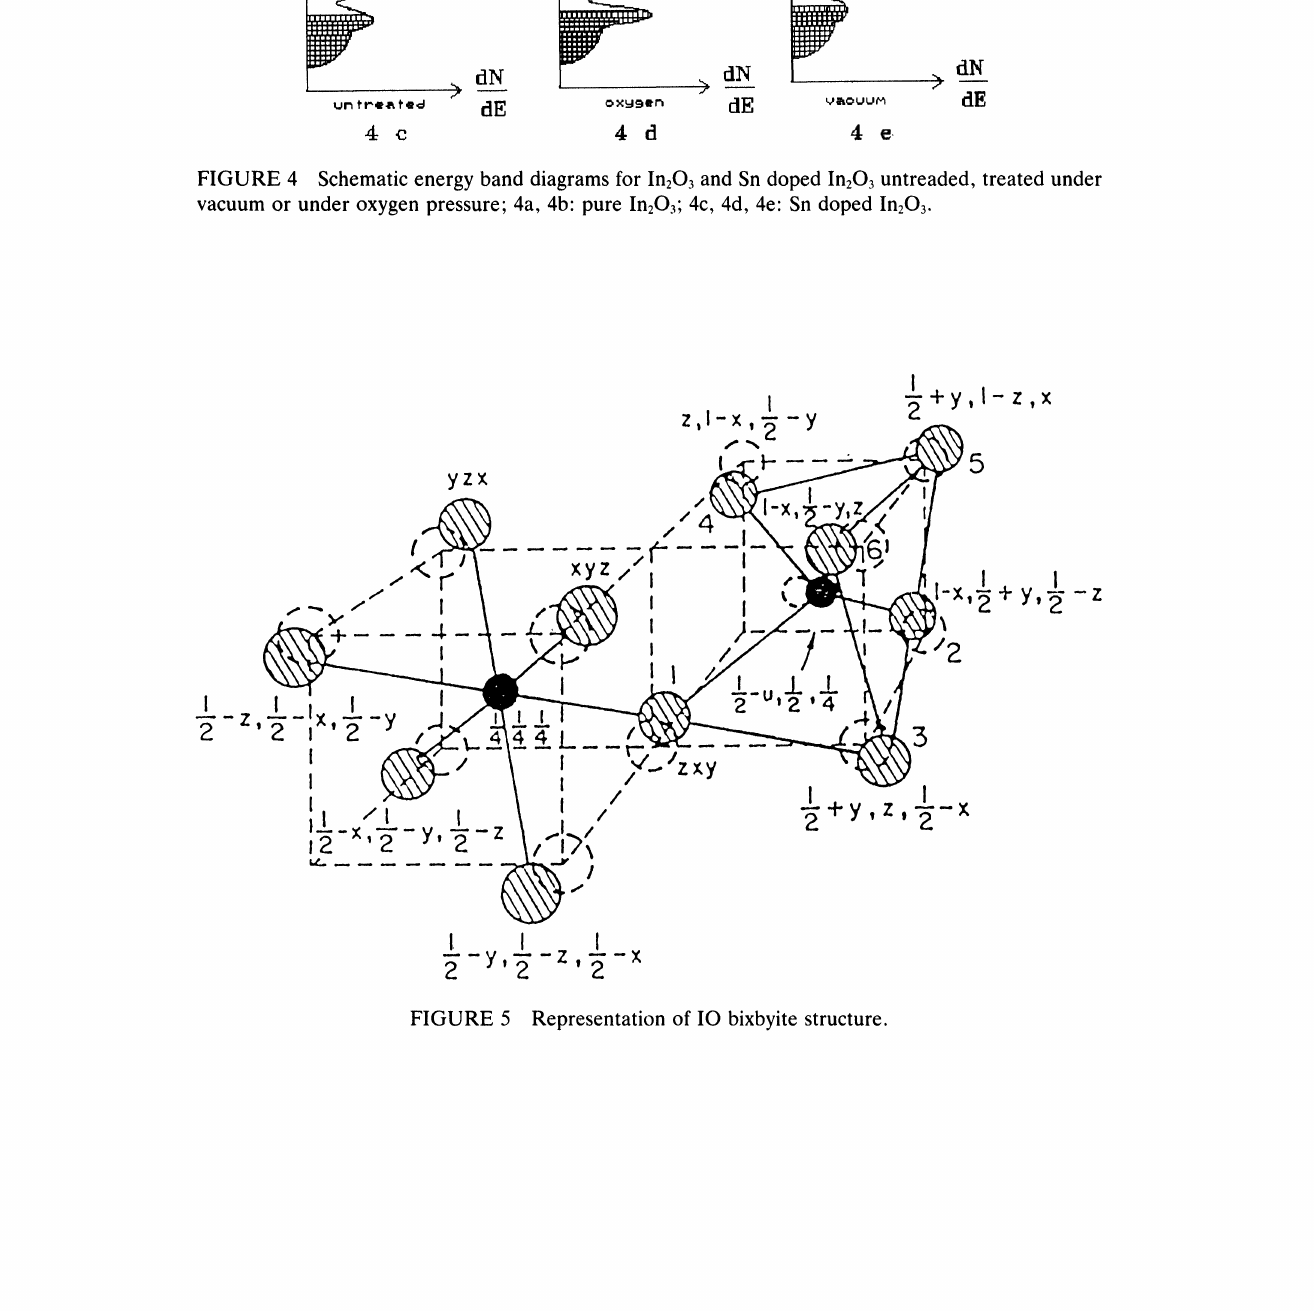
FIGURE 5 Representation of IO bixbyite